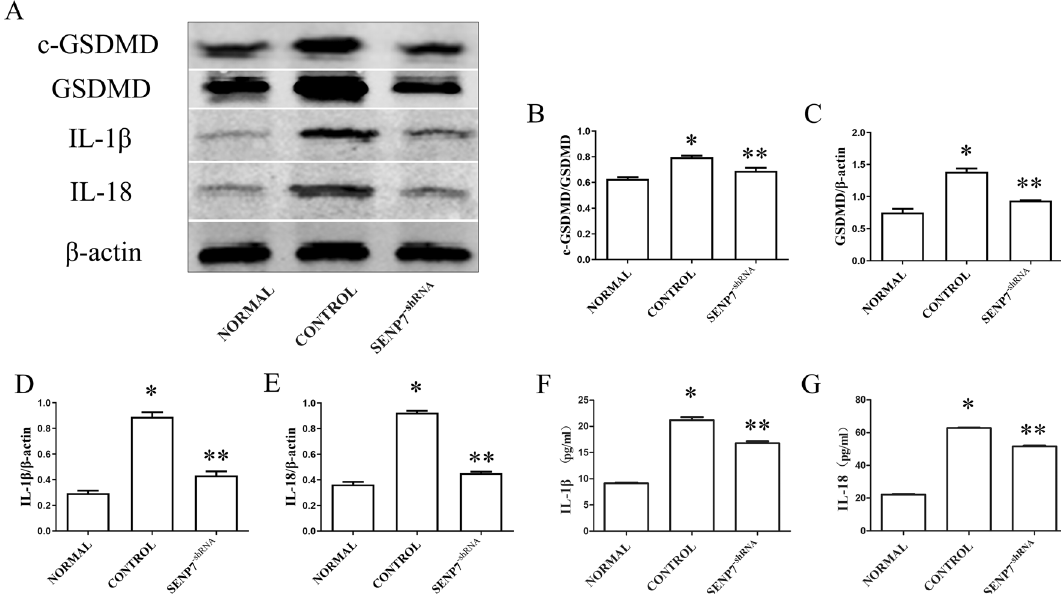
Figure 3. SENP7 knockdown inhibits pyroptosis in Raw 264.7 cells. ( A ) Cleaved-GSDMD, GSDMD, IL-1β and IL-18 expression levels detected by western blot assay; ( B – E ) The relative protein expression levels from three independent experiments are represented as the density of Cleaved-GSDMD, GSDMD, IL-1β and IL-18 bands normalized to that of GSDMD or β-actin bands. ( F , G ) The expression levels of IL-1β and IL-18 in supernatants detected by ELISA assay. NORMAL: Raw 264.7 cells without any treatment; CONTROL: Raw 264.7 cells treated with LPS + ATP; SENP7 -shRNA : SENP7 stable knockdown Raw 264.7 cells treated with LPS + ATP. Compared with the NORMAL group, * p < 0.05, compared with the CONTROL group, ** p < 0.05.